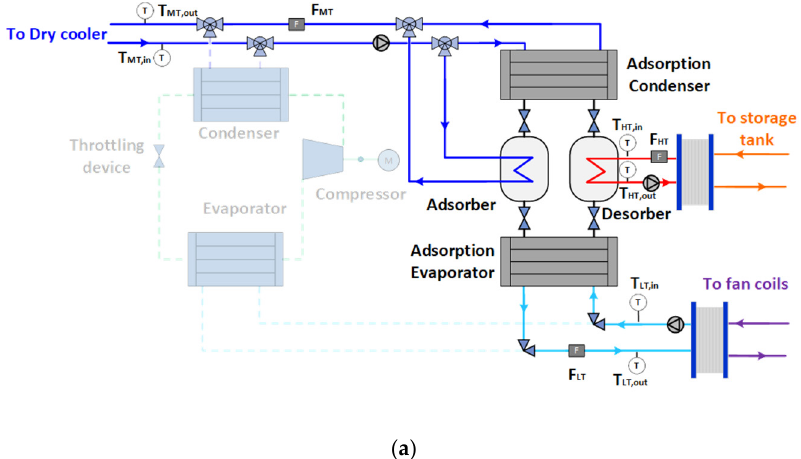
Figure 1. Schematic of system prototype with all the involved measuring devices.